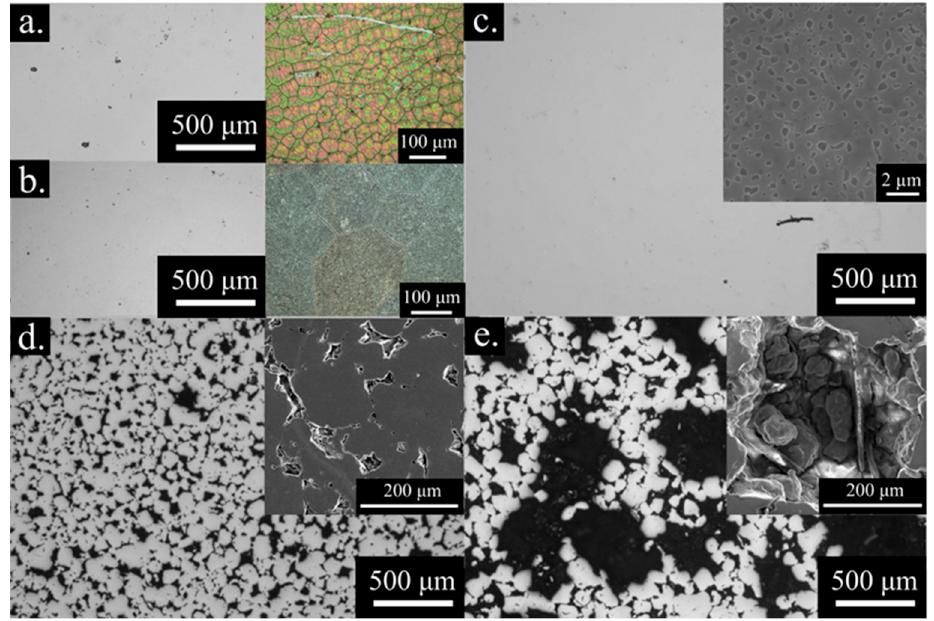
Figure 2. Optical and SEM microphotographs of Ti23Mo alloys obtained by different processing approaches: Arc melted ( a ), arc melted annealed at 800 °C/24 h ( b ), MA for 48 h and: hot pressed at 800 °C/5 min ( c ), cold-pressed and sintered at 800 °C/0.5 h ( d ) and cold-pressed with NH 4 HCO 3 and sintered at 1150 °C/10 h ( e ).